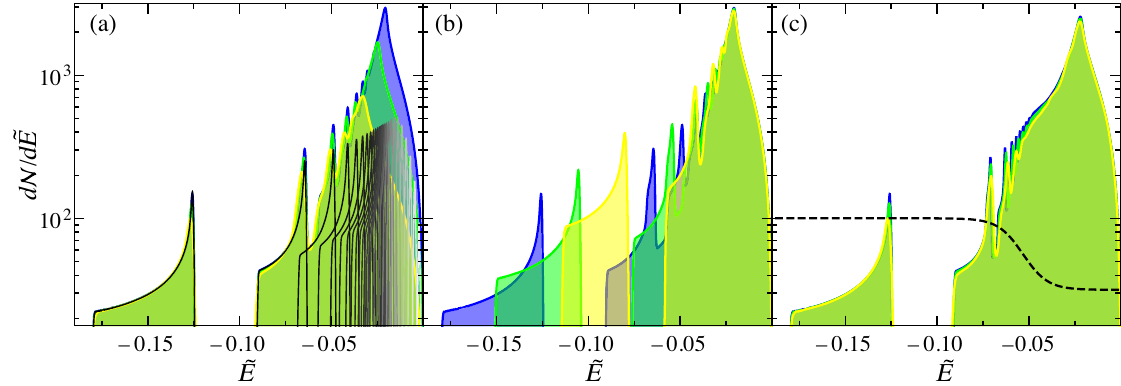
FIG. 8. Density of states computed by convolving the spectrum using a Gaussian distribution for three ν values: 40 (yellow), 70 (green), and 100 (blue). (a) The energies are scaled with ν 5 . 5 , the “ band ” scaling. Individual band contributions for ν ¼ 100 , obtained from the dispersion curves in Fig. 6, are shown in gray scale. (b) The energies are scaled with ν 6 , the “ overlap ” scaling. (c) The energies and densities of states are scaled via the “ universal ” scaling connecting the band and overlap regions. The interpolating tanh function connecting the two regimes is overlayed. The FWHM of the convolving Gaussian distribution is approximately 0.0235; for details, see Appendix